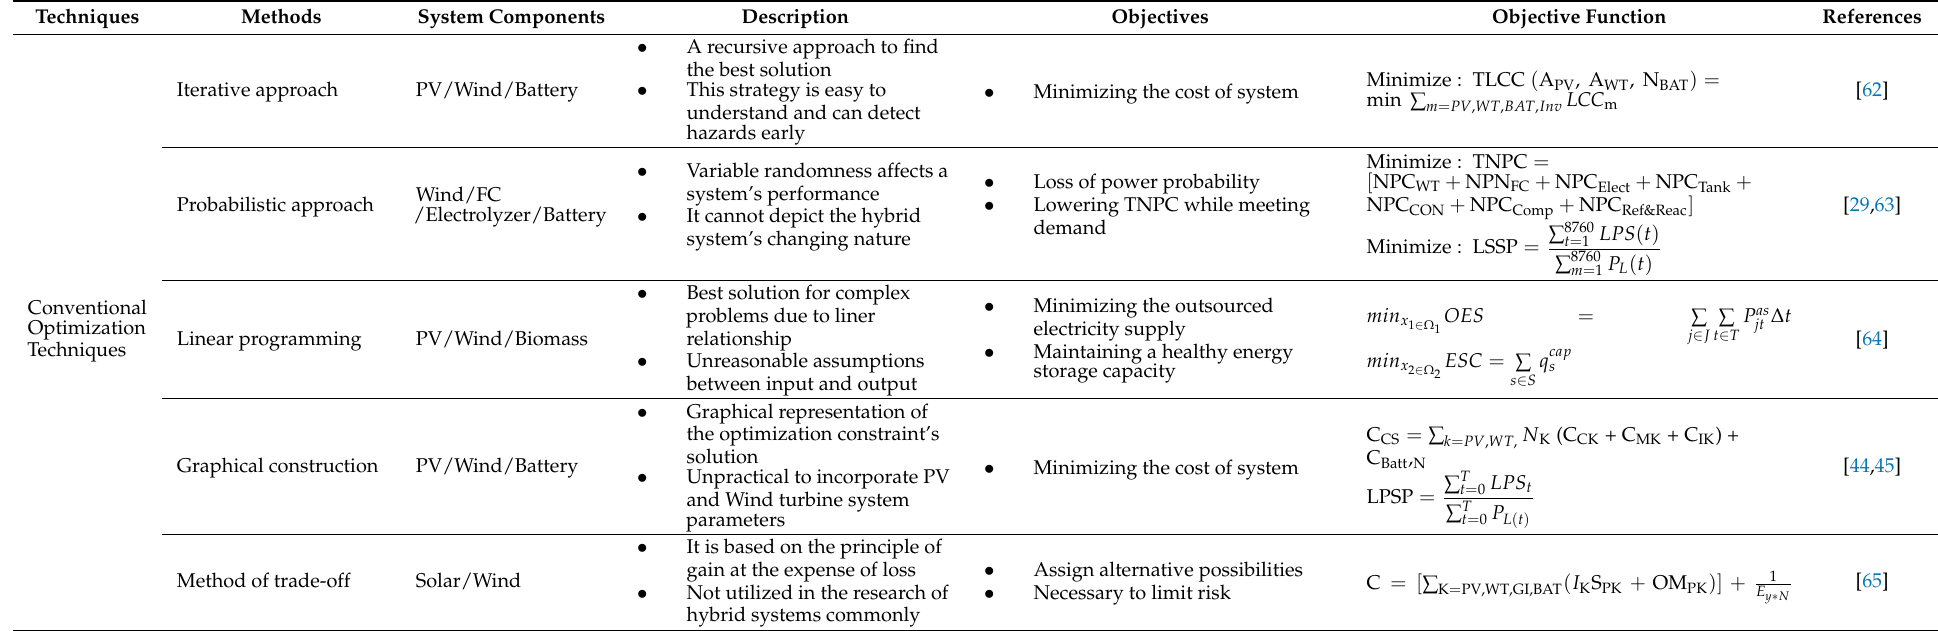
Table 2. Conventional optimization techniques used in